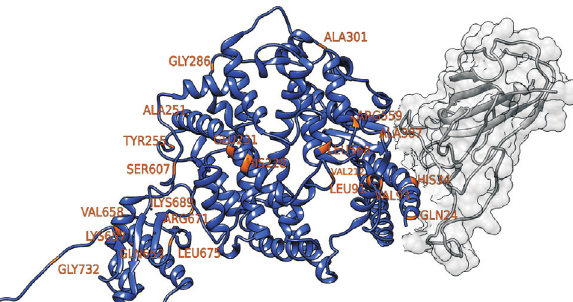
Figure 1 - Structural analysis of sites under positive selection in placental mammals (orange) of human ACE2 (blue) binding to SARS-CoV2 spike glycoprotein (gray). The Protein Data Bank (PDB) ID is 6M17 (Yan et al. ,